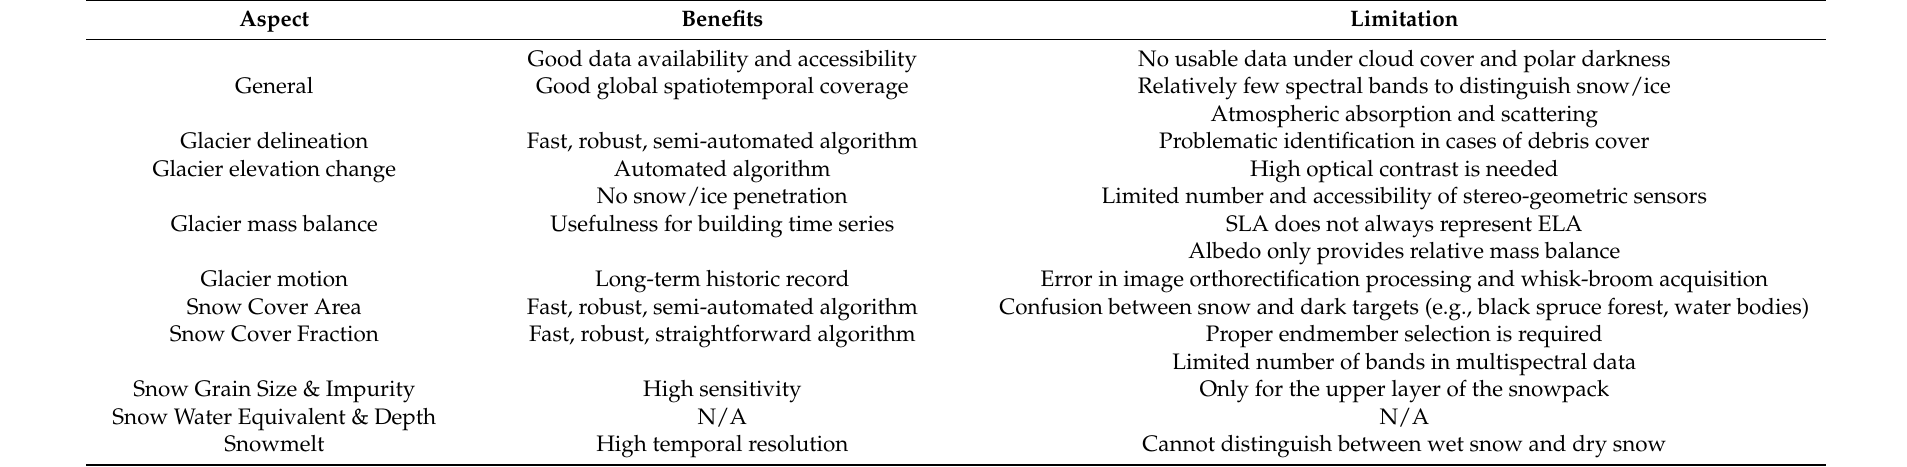
Table 3. Benefits and limitations of optical imagery for cold region monitoring.